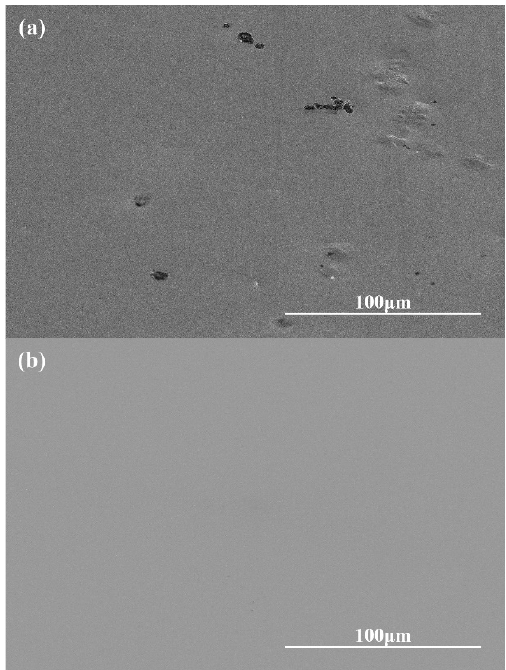
Figure 9. SEM images of the sample surface. ( a ) before polishing; ( b ) after polishing.